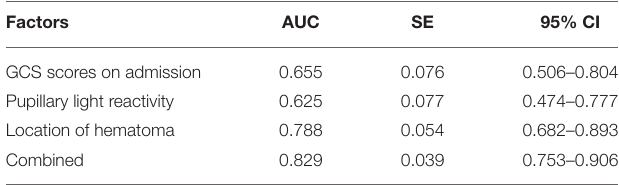
TABLE 3 | The AUC values under the ROC